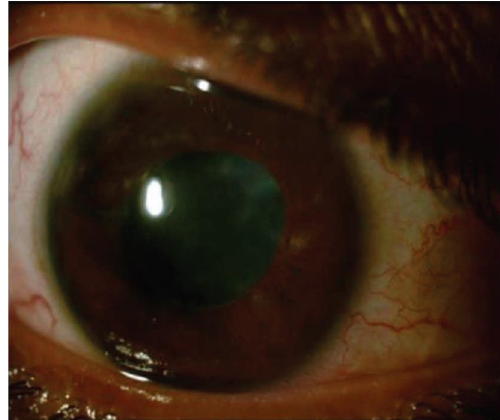
Figure 3: Showing uveitis in right eye complicated with posterior synechiae, poorly dilated pupil and complicated